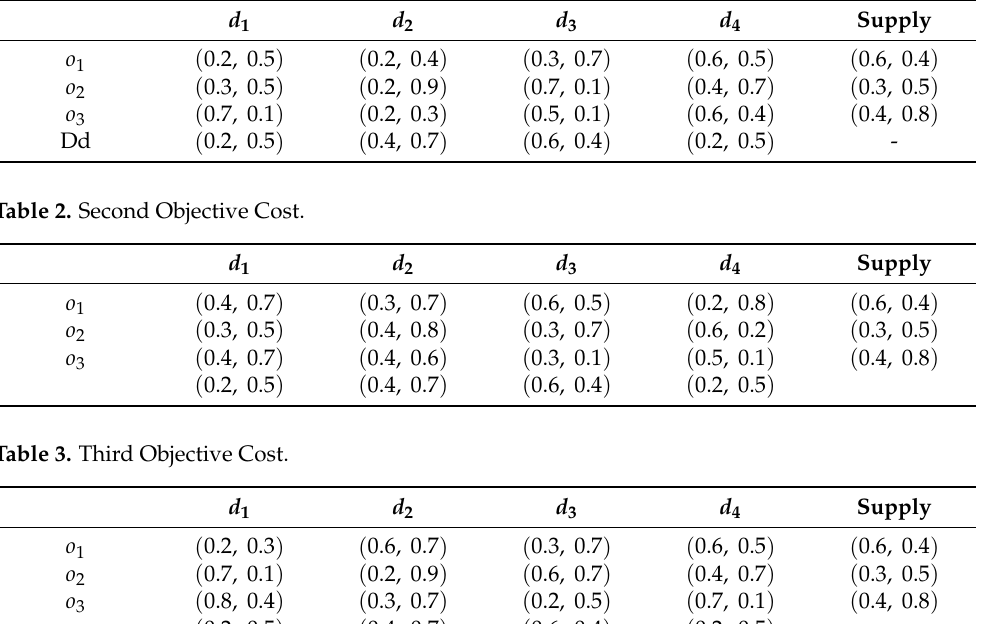
Table 1. First Objective Cost.